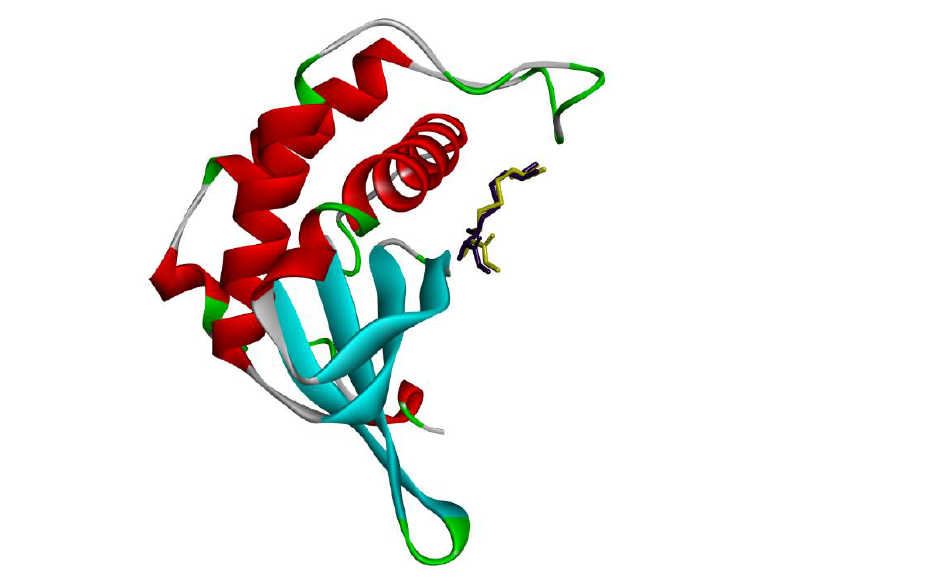
Figure 2. Redocking of the (2s)-2-amino-4-[(2r,3r)-2,3-dihydroxy-3-n-hydroxycarbamoyl-propylmercapto] butyric acid ligand at the LuxS active site (PDB ID 2FQO). In yellow, the best pose of the crystallized ligand generated by the GoldScore function, and, in lilac, its crystallographic conformation. The beta sheets of the protein are represented in cyan blue and the alpha helices in red. The figure was generated by the Biovia Discovery Studio Visualizer software (v19.1.0.18287, BIOVIA, San Diego, CA, USA).